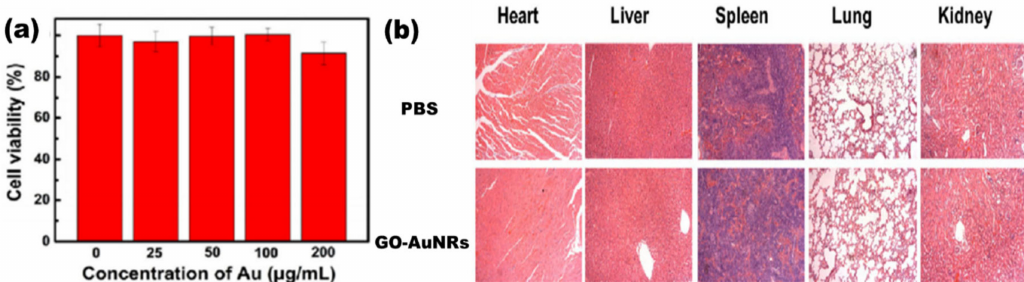
Figure 8. ( a ) Cytotoxicity of GO–PSS–AuNRs solutions with various Au concentrations against SW1990 cancer cells. ( b ) Histological images of the heart, liver, spleen, lung, and kidney of the mice, obtained one month after intravenous injection with phosphate bu ff er solution (PBS, 100 µ L) and GO–AuNRs (0.026 M, 100 µ L). Adapted from [38], with permission from Springer Nature,